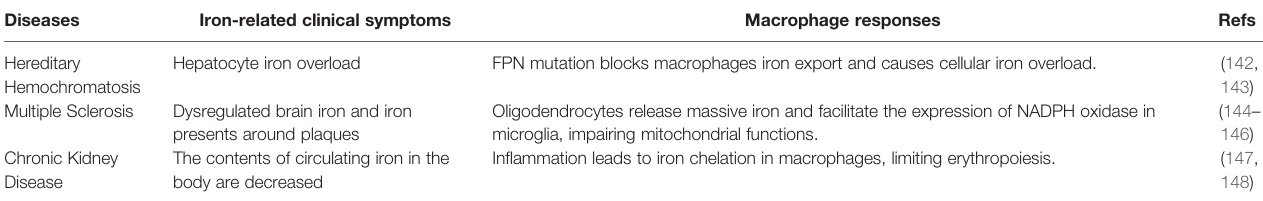
TABLE 2 | Iron in other macrophage-associated